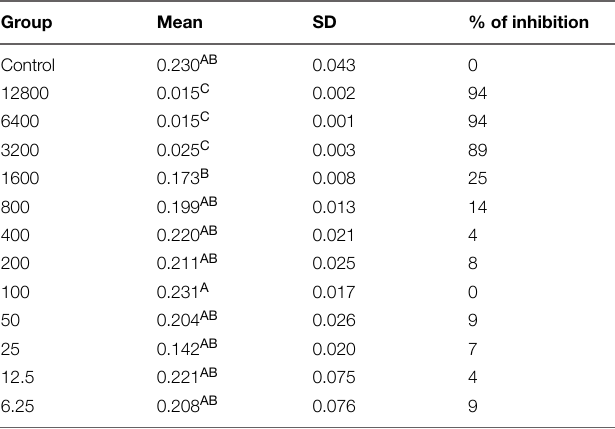
TABLE 1 | Mitochondrial dehydrogenase activity of gingival fibroblast exposed to histatin 5 solutions. Group SD % of